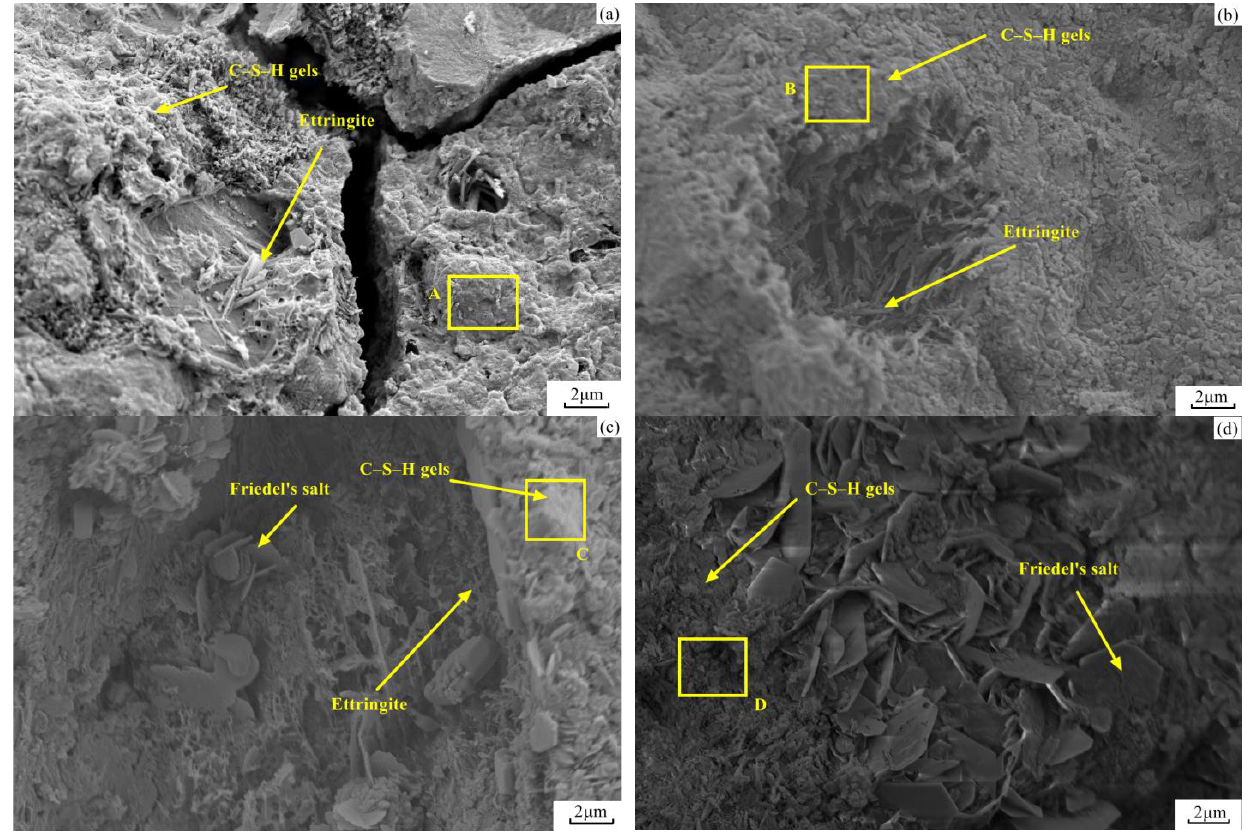
Figure 9. Micromorphology of a paste of different ASR-to-DG ratios at 180 days: ( a ) A1, ( b ) A2, ( c ) A3, and ( d ) A4.